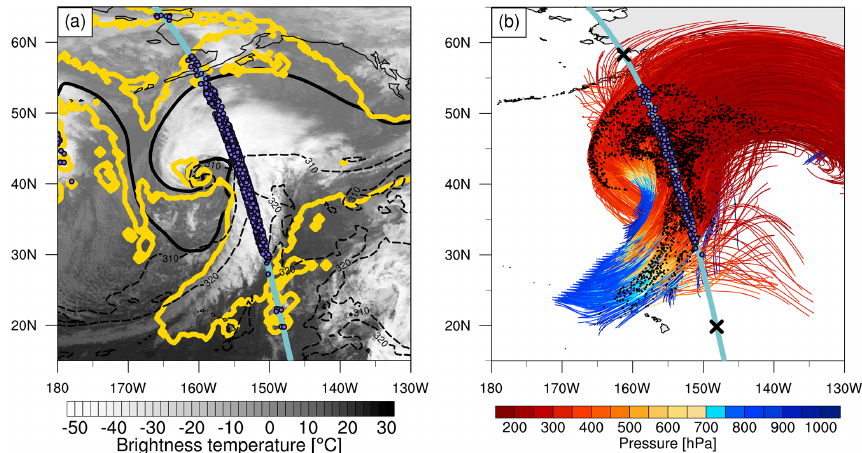
Figure 2. Case study of a North Pacific WCB at 00:00UTC on 3 January 2014. (a) Infrared satellite image (brightness temperature in ◦ C) derived from the GridSat-B1 data (Knapp et al., 2011) and, from ERA5, the 2pvu contour at 315K (solid black), θ e (dashed black contours at 310 and 320K) and grid points with at least one WCB trajectory (yellow). The blue line marks the track of the A-Train, and the purple dots show matches between WCB air parcels and the satellite track. (b) The 2 day WCB trajectories (coloured by pressure; hPa) starting at 06:00UTC on 2 January 2014. The positions of the trajectories at the time of the satellite overpass, 00:00UTC on 3 January, are shown by black and purple dots, with the purple dots indicating matches with the satellite track (blue line). The segment of the satellite track between the two black crosses indicates the region shown in Fig.